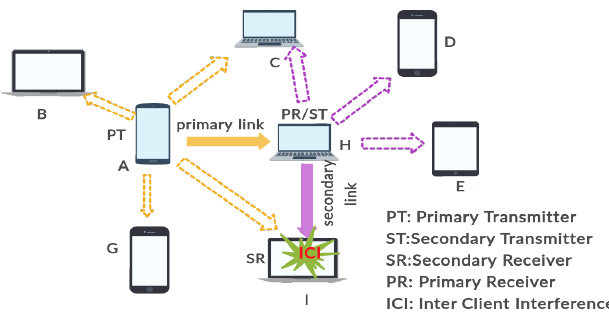
Figure 1. Inter-Client Interference in Ad hoc